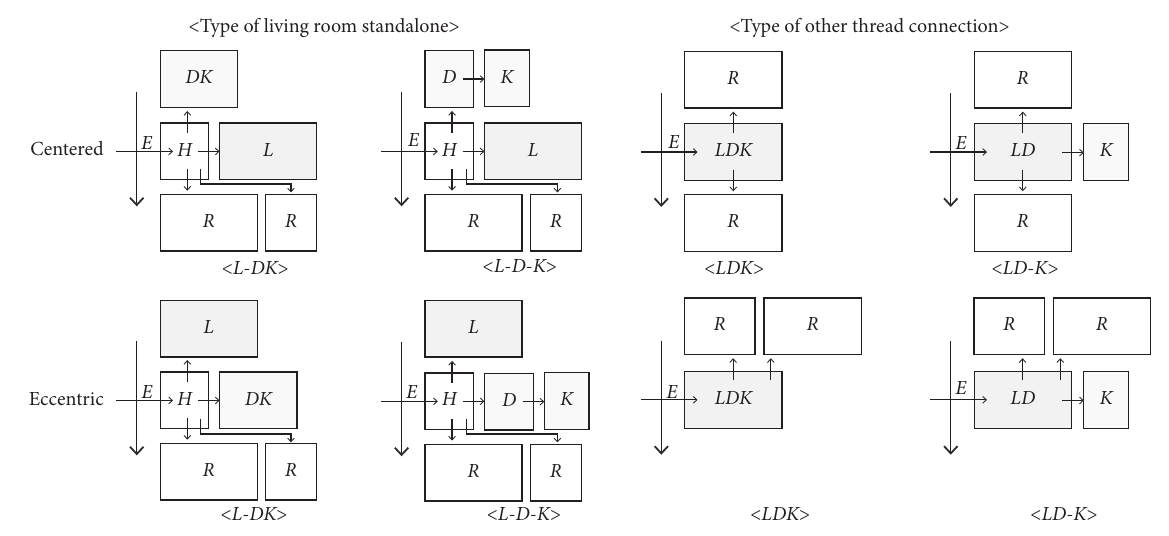
Figure 3: Classification of physical space. Table 5: Classification of typology.